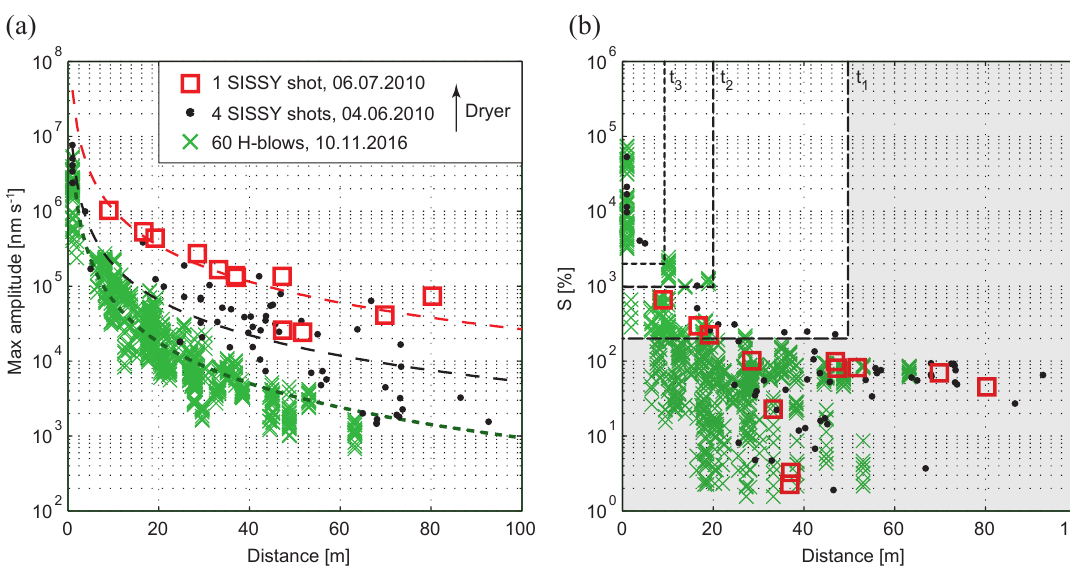
Figure 11. (a) Maximum absolute zero-to-peak amplitudes with distance to the source of SISSY calibration shots carried out at Super-Sauze 4 June (dots) and 6 July (squares) 2010, and hammer blows (crosses) carried out at Pechgraben, 10 November 2016. Dashed lines indicate log–log regression curves. Note the lower attenuation with dryer conditions. (b) Scatter about the median amplitude ( S ) of the calibration datasets presented in (a) . S values of natural events higher than 200, 1000 and 2000% are inferred to display source–receiver distances of about 50, 20 and 10m ( t 1 t 2 t 3 ),